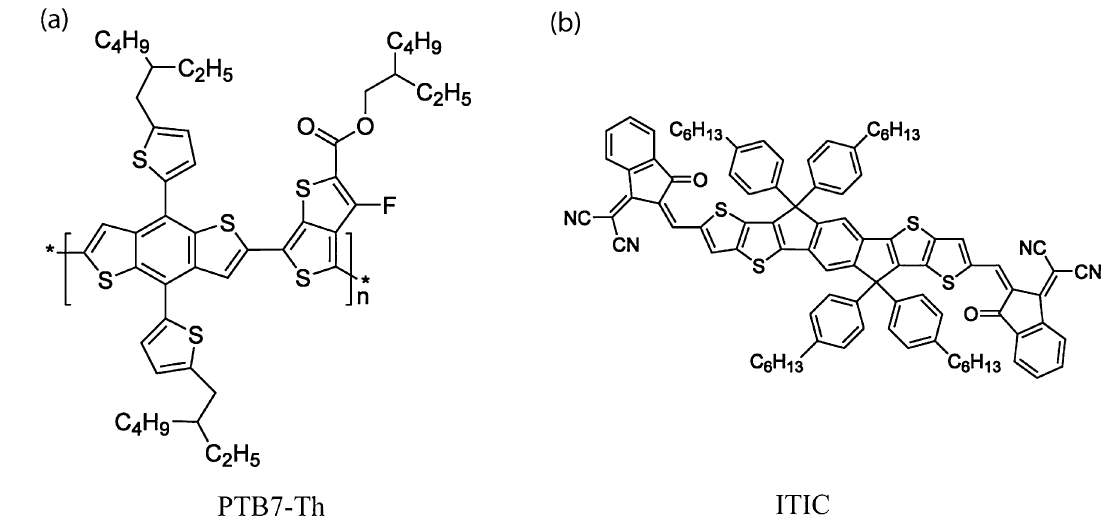
Figure 1. Chemical structures of ( a ) electron-donating polymer (PTB7-Th), and ( b ) electron-accepting small molecule